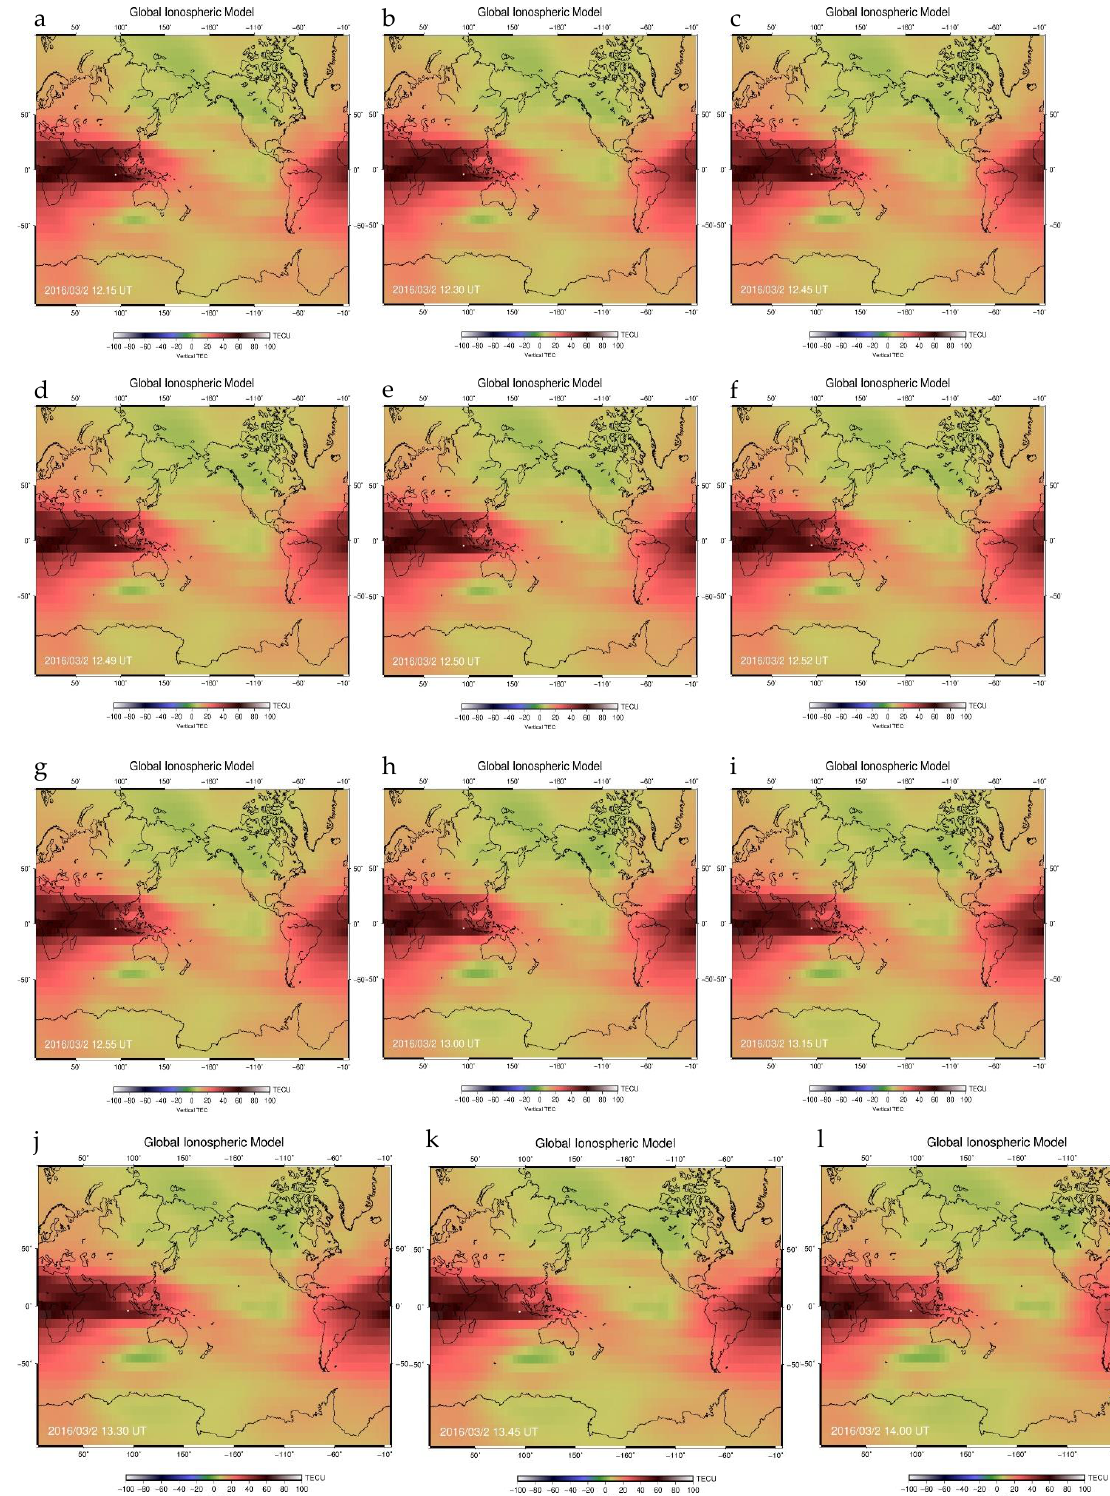
Figure A3. Global ionospheric maps processed during the 2016 West Sumatra earthquake on March 2, 2016 ( a – l ). The data started from ~35 min ( a ) before the earthquake to ~70 ( l ) minutes after the earthquake time (12:49:48 UT), with data intervals every 15 min. EIA propagation moves westward, which is characterized by an increase in electrons around the equatorial